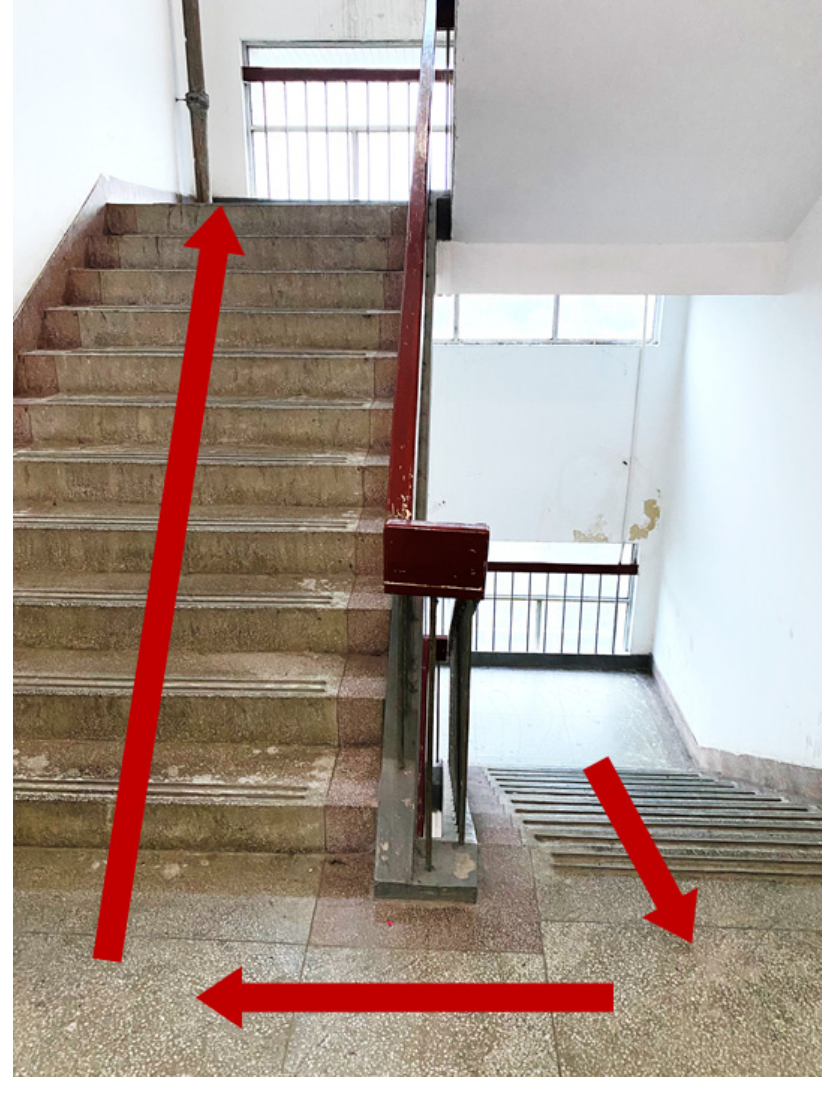
Figure 15. Experimental site e of indoor experiment . Table 5. Elevation error (m) obtained by different schemes .